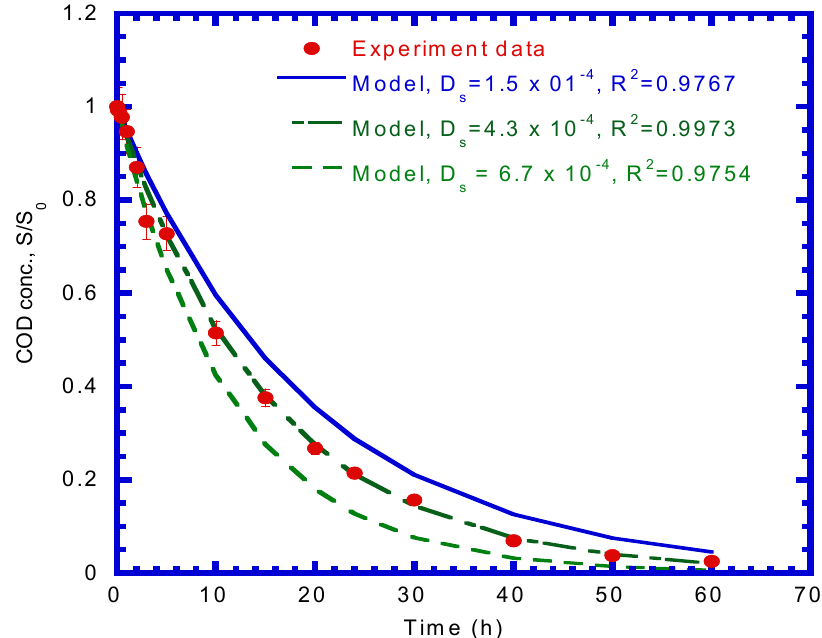
Figure 4. Adsorption model best fit to determine effective diffusivity ( D s ) in batch